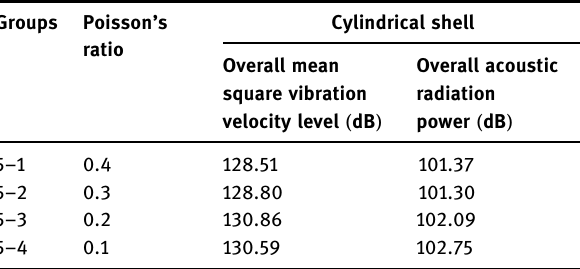
Table 5: The overall vibration level and the overall sound power level of the shell with di ff erent Poisson ’ s ratios of materials Groups Poisson ’